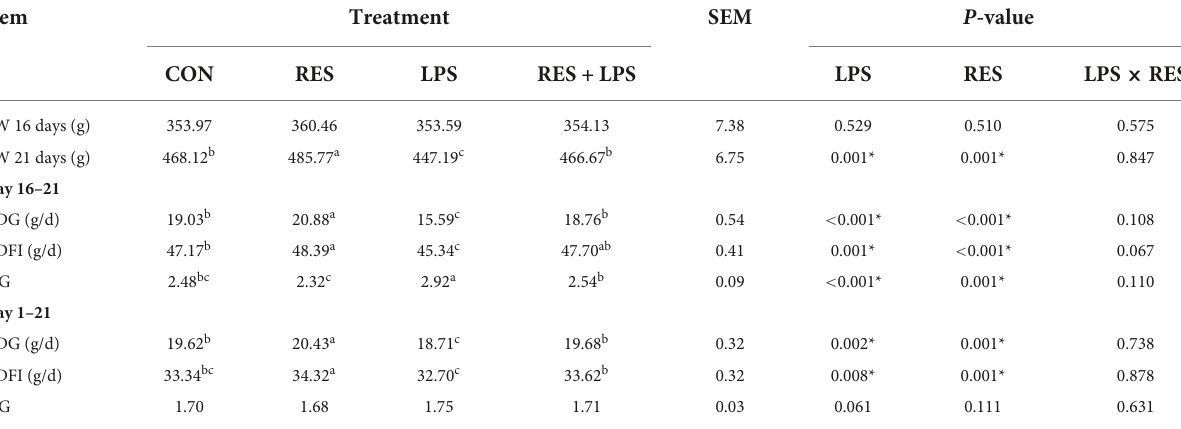
TABLE 3 Effect of dietary resveratrol supplementation on growth performance in yellow-feathered broilers with lipopolysaccharide 1 .